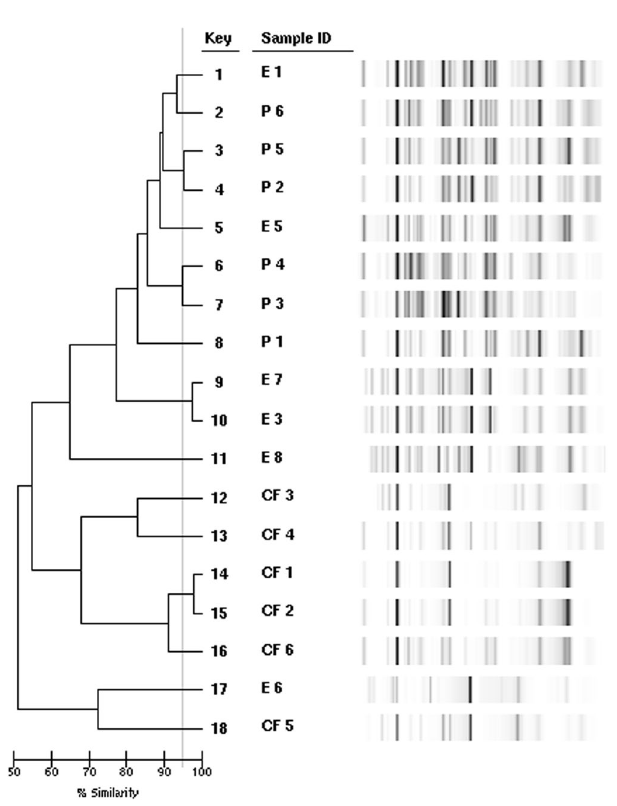
Figure 10. Dendrogram of cluster analysis estimated by DiversiLab ® . 18 E. dermatitidis isolates of various origins were analysed and clustered after Kullback-Leibler algorithm. Line indicates 95%